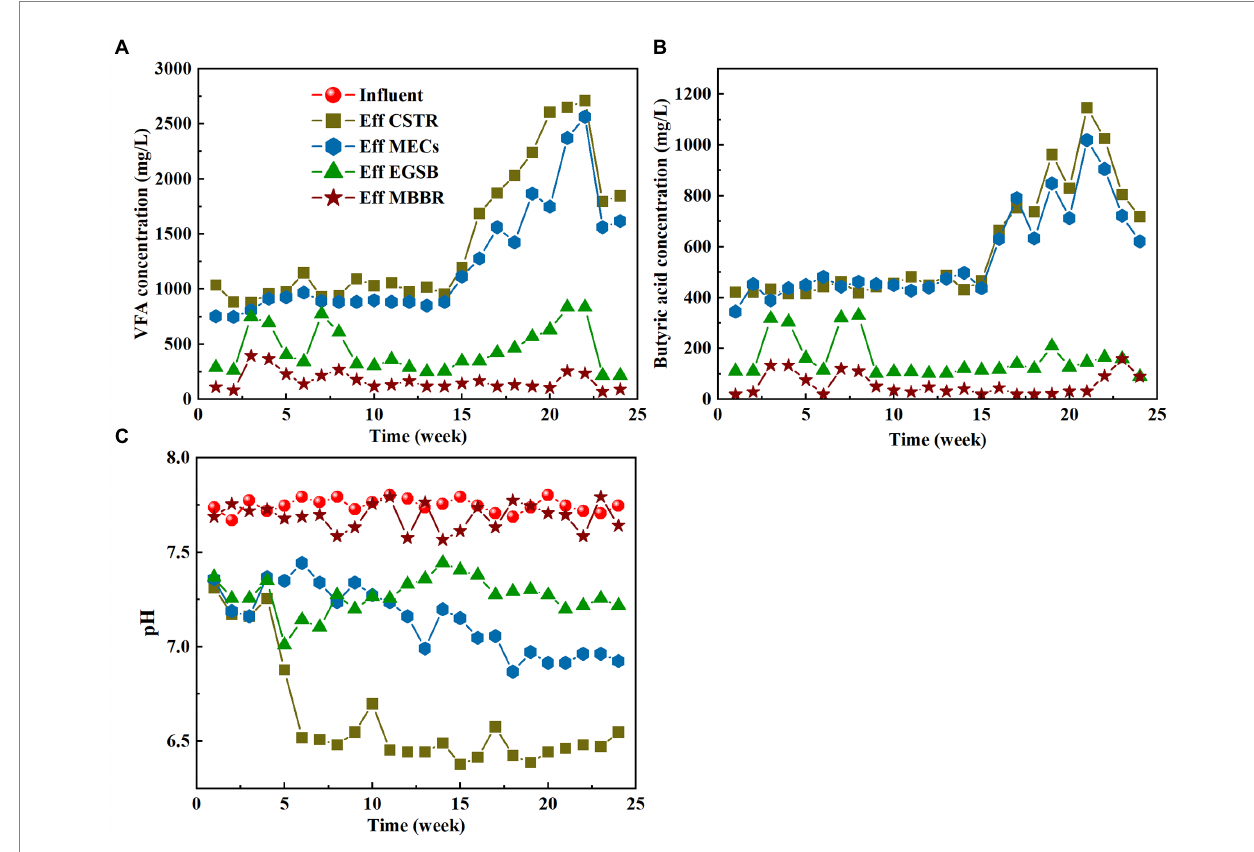
FIGURE 3 Variation characteristics of VFA ( A ), butyric acid ( B ) and pH ( C ) in different process